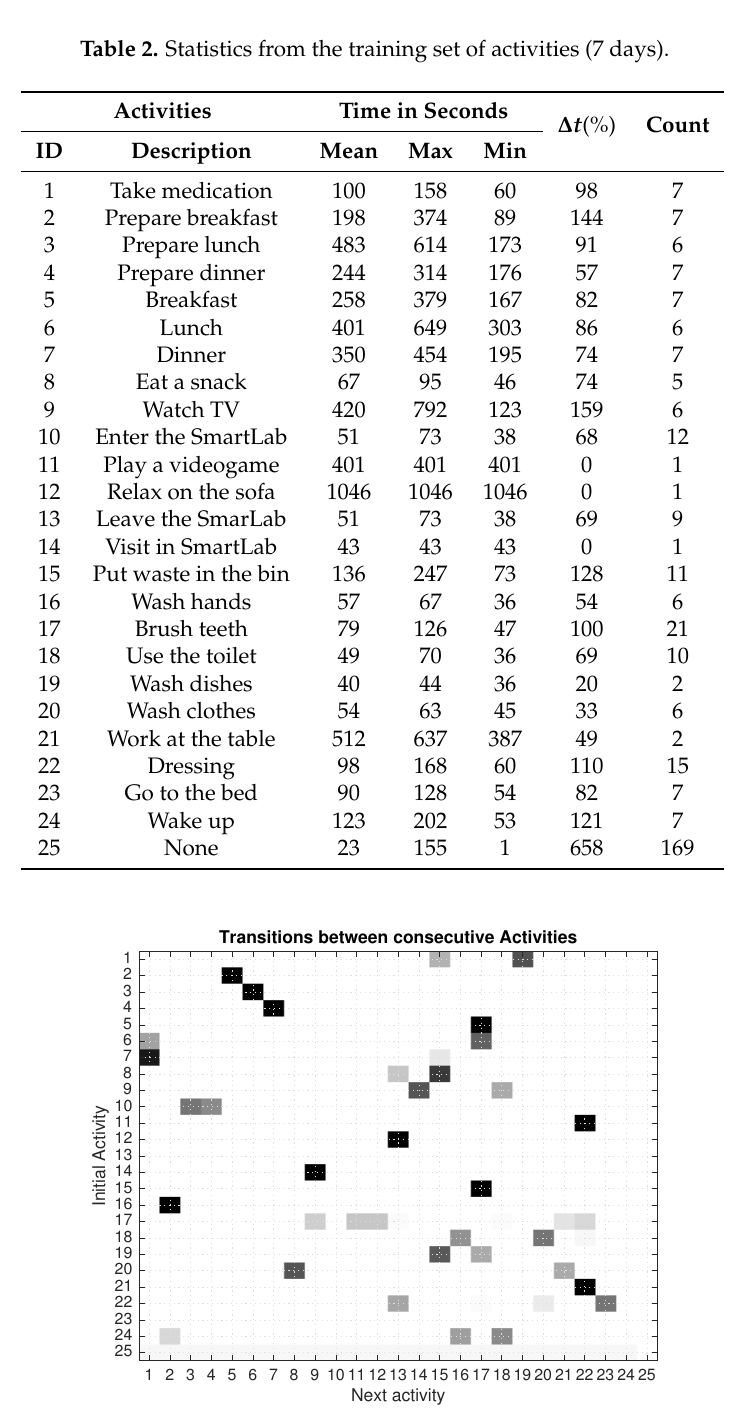
Figure 3. Transition matrix relating activities with the next activity (for seven-days training